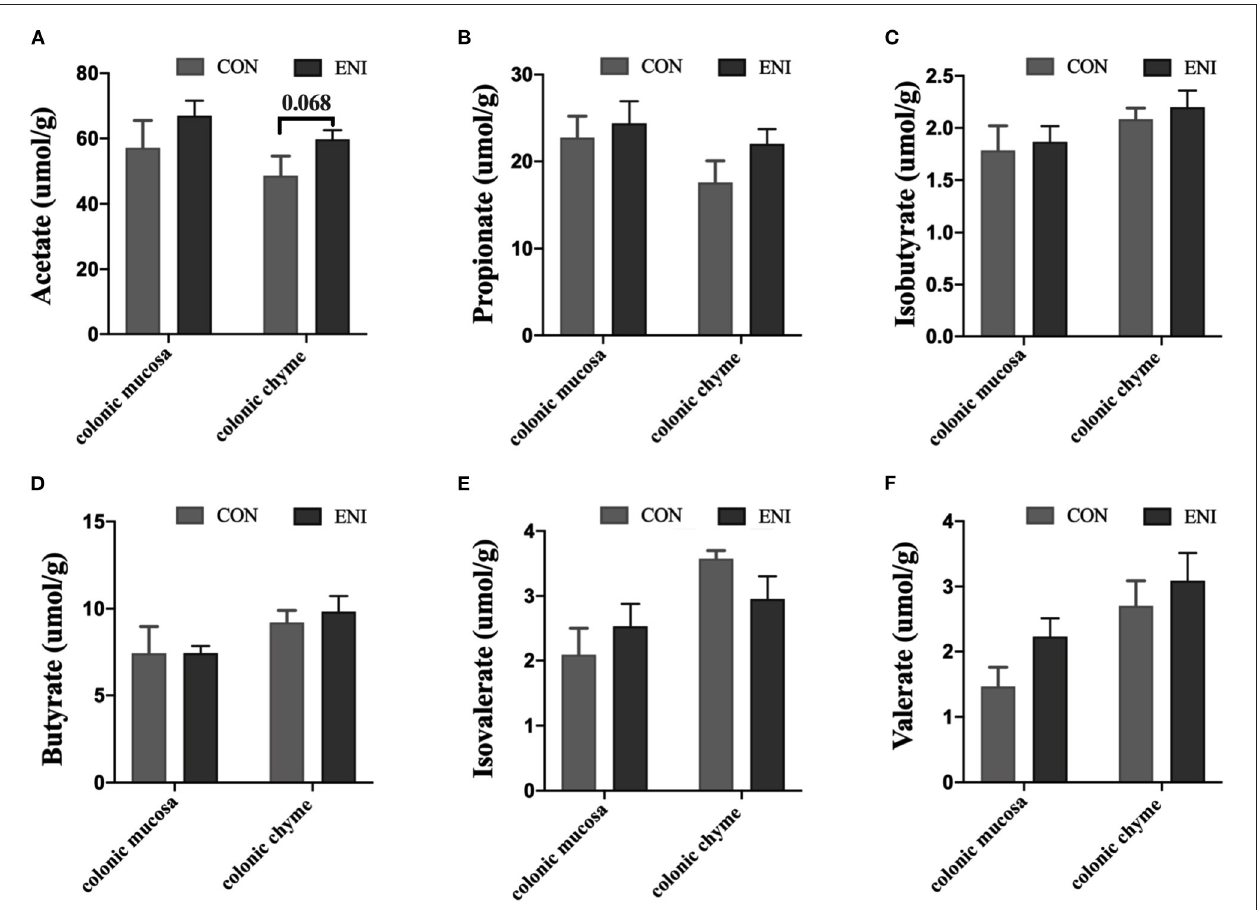
FIGURE 5 | Effects of early-life nutrition interventions on concentrations of SCFAs in the colonic mucosa and colonic chyme. CON, control group, ENI, early-life nutrition interventions group. (A) Acetate acid. (B) Propionic acid. (C) Isobutyric acid. (D) Butyric acid. (E) Isovaleric acid. (F) Valeric acid. Data are expressed as mean ± SEM ( n = 4). The independent-samples t -test was used to compare data between two groups. * P <